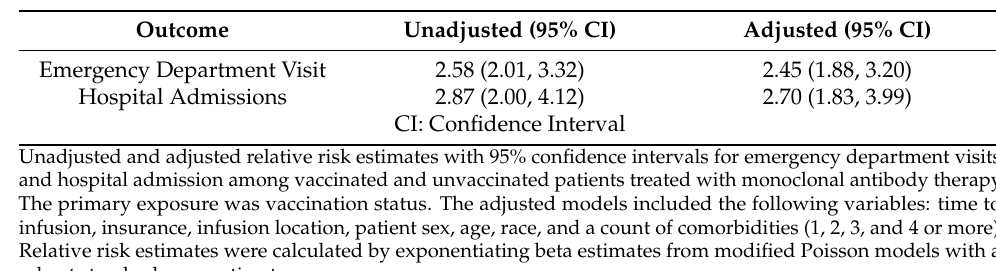
Table A1. Relative risk estimates from modified Poisson regression models that correspond to Figure